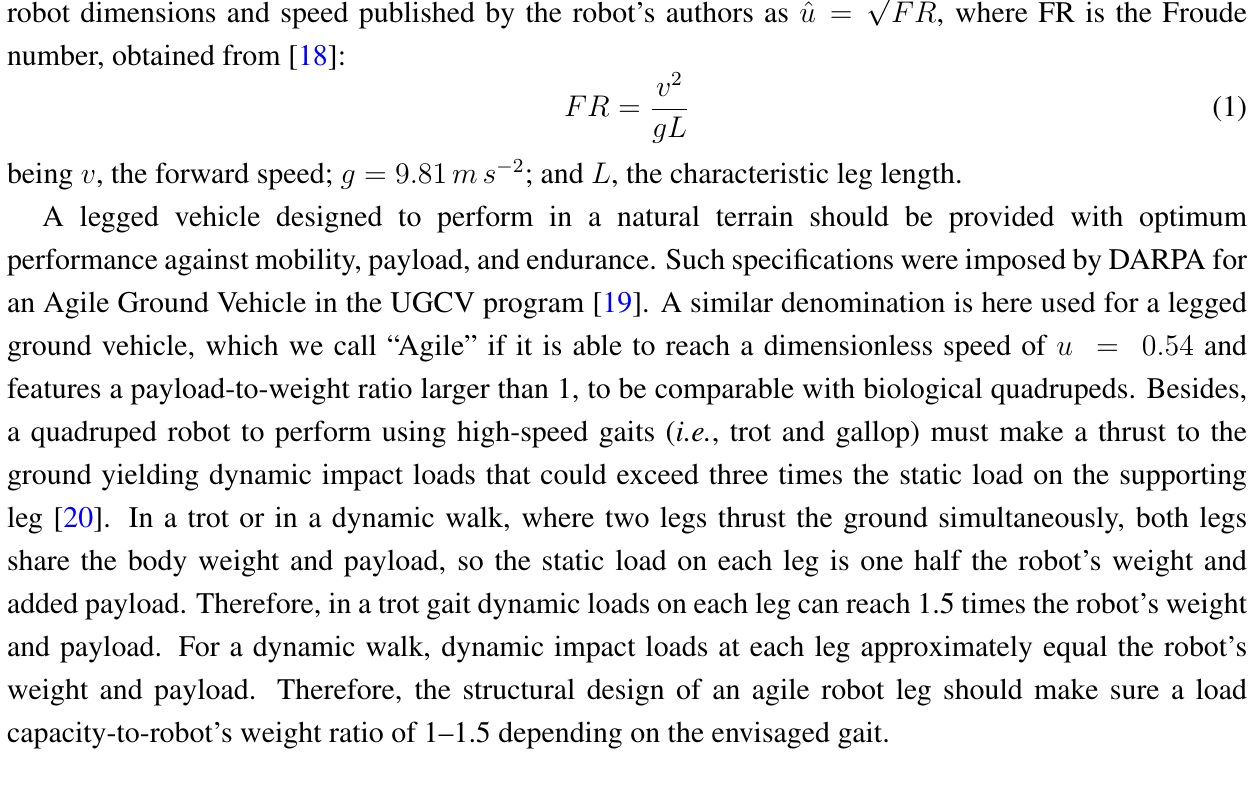
Figure 1. State-of-the-art agile robots: ( a ) KOLT, joint project by Stanford University and The Ohio State University, image courtesy of Prof. Waldron; ( b ) HyQ, image courtesy of the Italian Institute of Technology; ( c ) BigDog, image courtesy of Boston